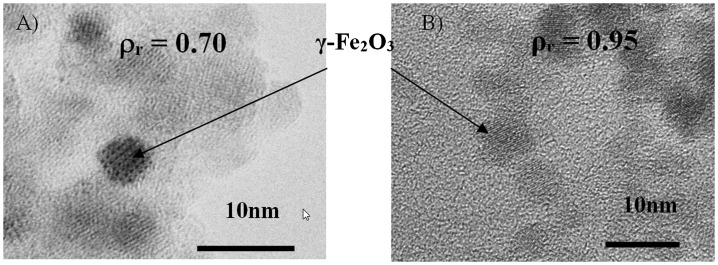
(a) TEM micrograph of γ-Fe2O3/SiO2 composites ρ
r = 0.70, (b) ρ
r = 0.95.